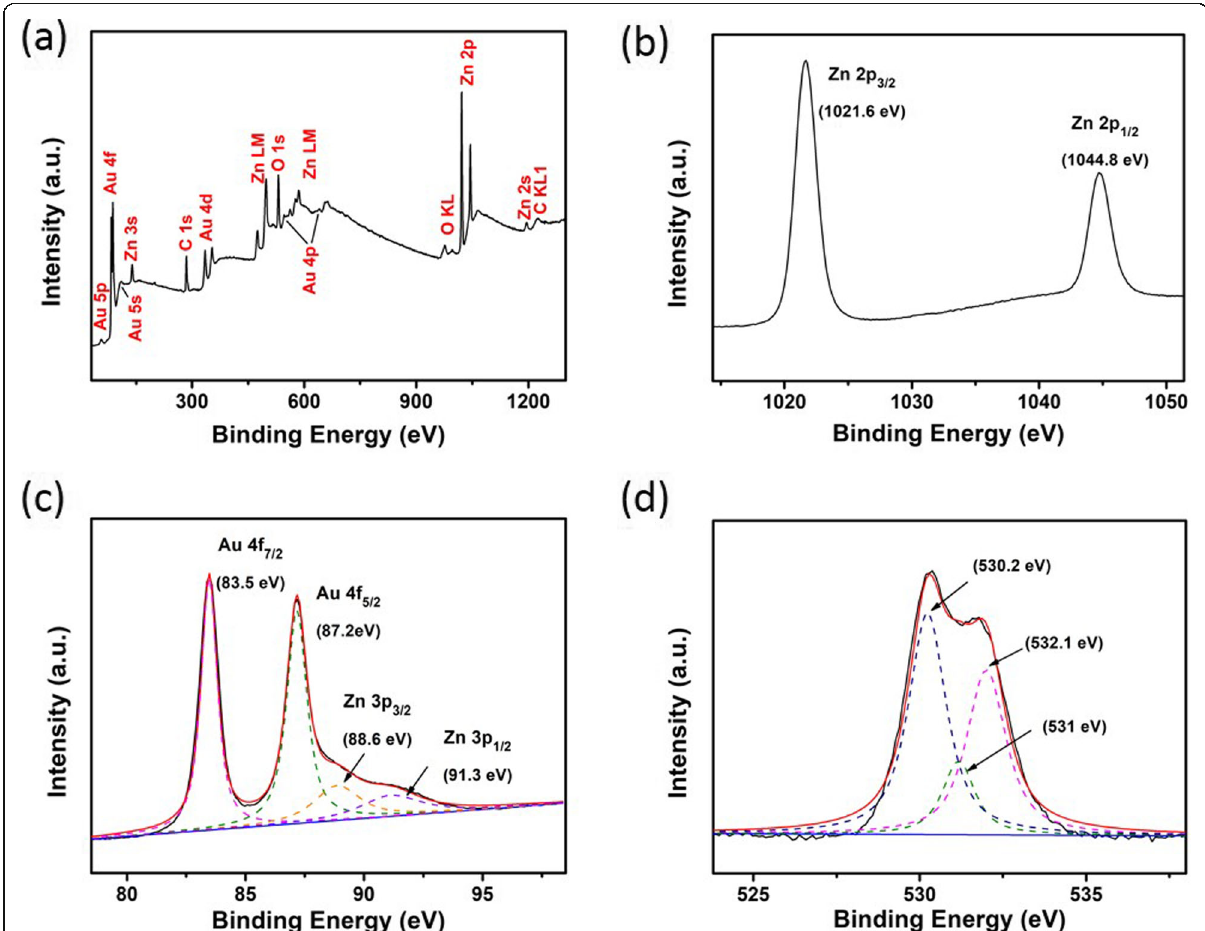
Fig. 3 XPS spectra of 2D ZnO-Au heterostructures. a Full survey scan spectrum. b Zn 2p region. c Au 4f and Zn 3p regions. d O 1 s